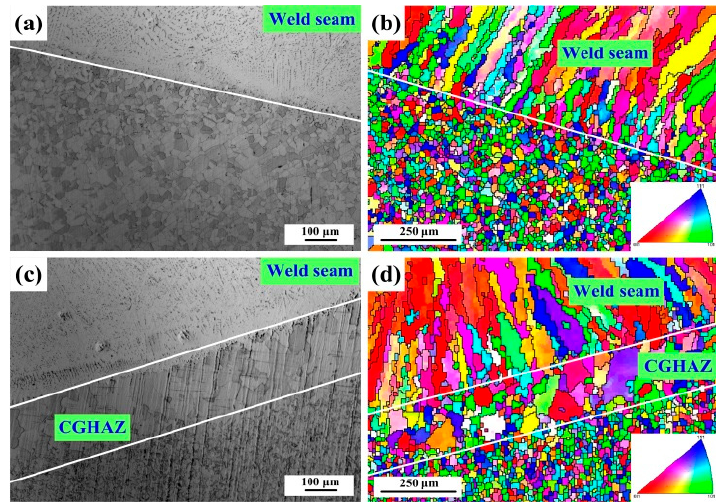
Figure 6. Microstructures ( a ) observed by OM and ( b ) an inverse pole figure (IPF) for 1670-8; and ( c ) observed by OM and ( d ) an IPF for 1670-14.